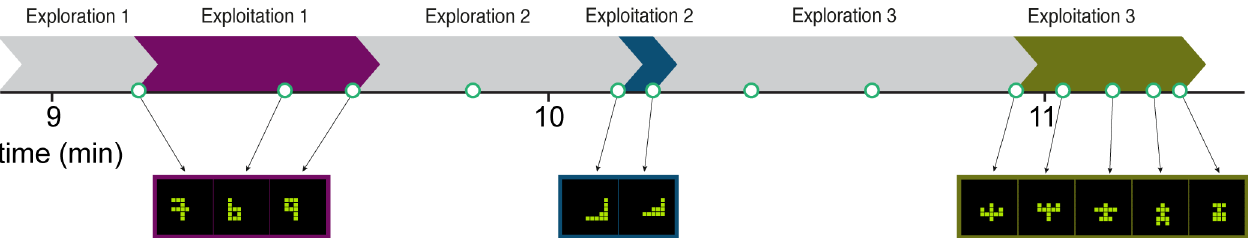
Fig 2. Search trajectories are segmented into exploration and exploitation phases. Segmentation uses the timing difference Δ t between gallery shape choices. Periods with increasing Δ t are labelledas exploration phases. An explorationphaseends with a decreasein Δ t, leadingto a sequenceof rapid gallery choices, labelledas exploitation phases (see Methods,and Section C in S1 File). Choices of shapes to the galleryare marked with an open circle.